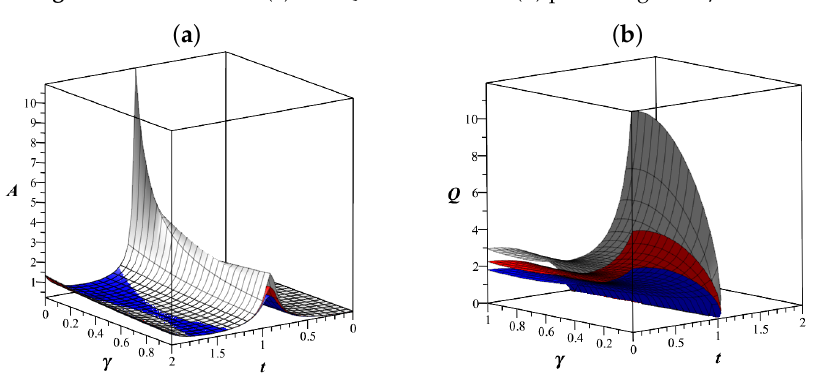
Figure 9. AFC surfaces ( a ) and Q-factor surfaces ( b ) plotted against γ and t .